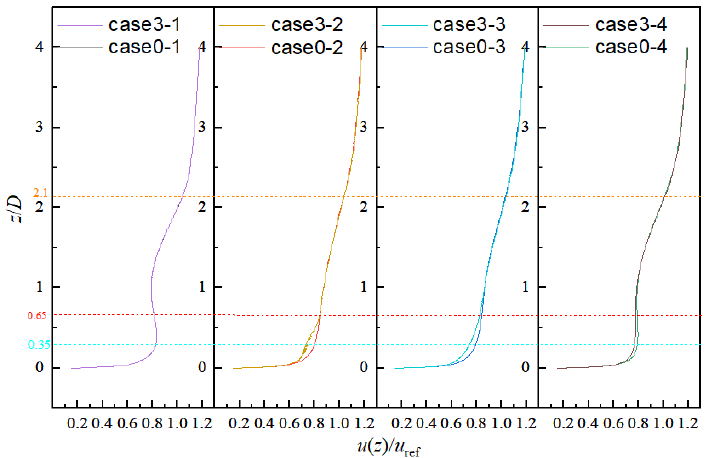
Figure 6. Comparison of vertical velocity wind profiles of Case 3 and Case 0.